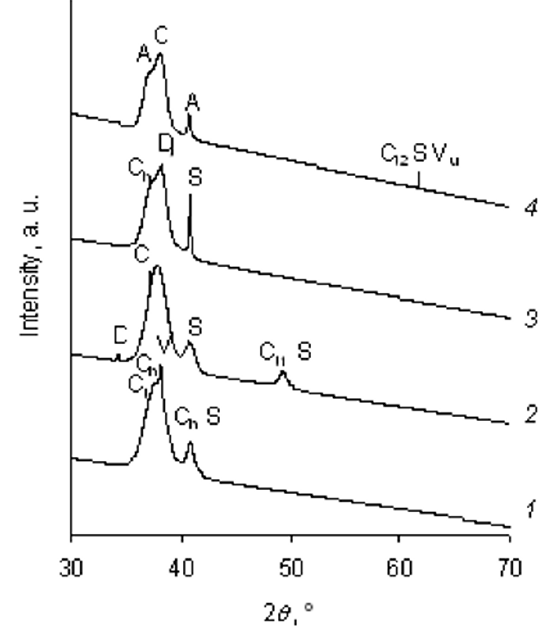
Figure 7. X-ray diffractograms of PA films first treated in